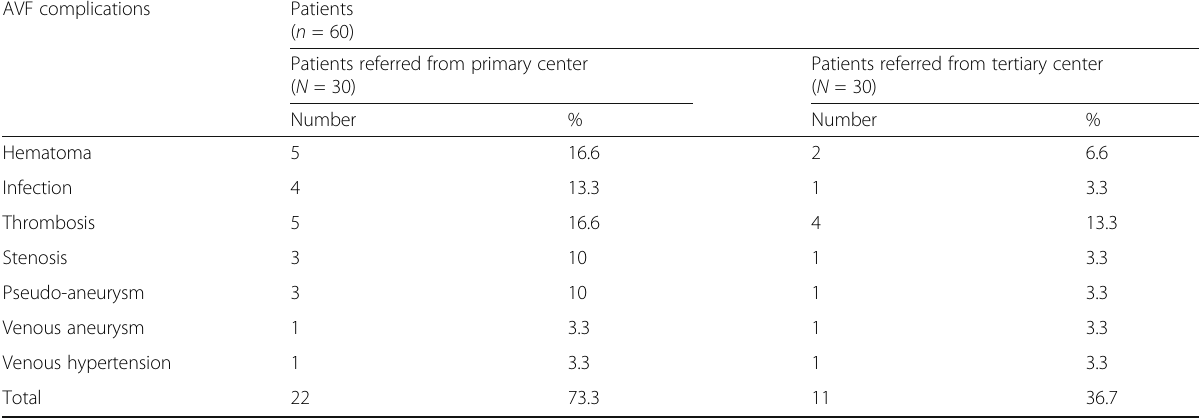
Table 1 Frequency of AVF complications among the included patients AVF complications Patients